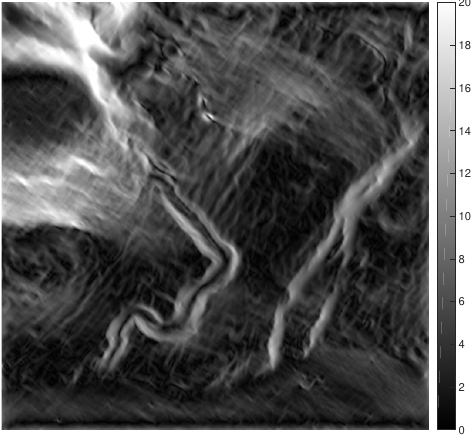
Figure 6. Slope map of the SAfS DTM.